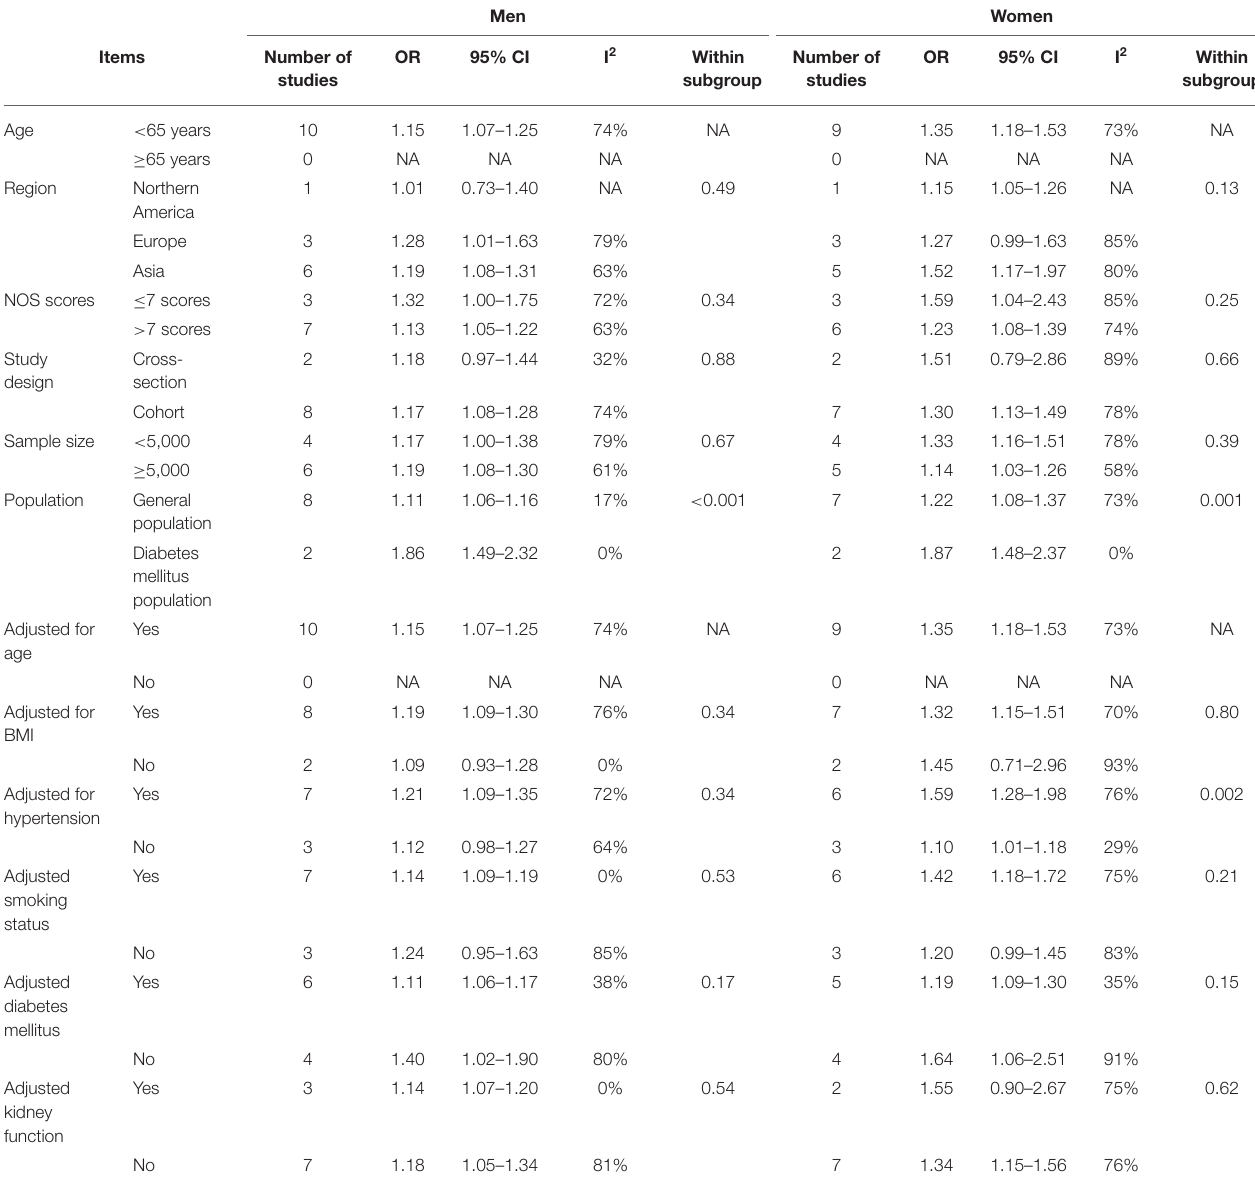
TABLE 2 | Subgroup analysis of serum uric acid and risk of atrial fibrillation in men and women, per 1 mg/dL increment. Men